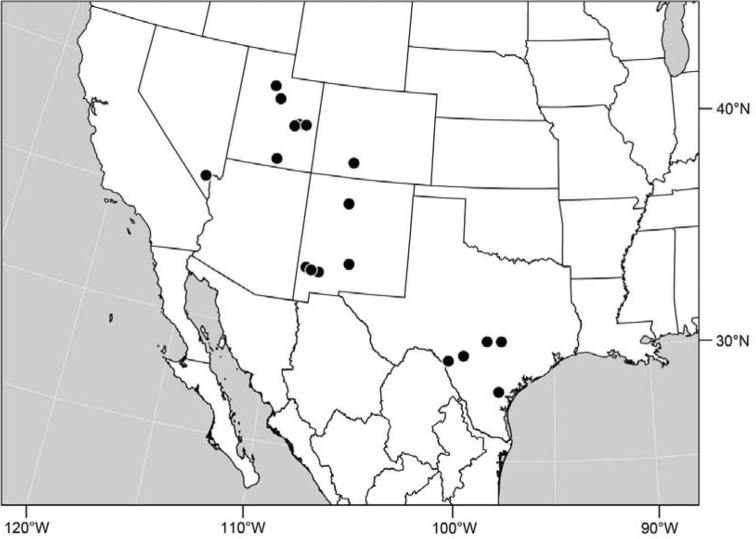
Distribution of Polytrichophora mimbres sp. n.